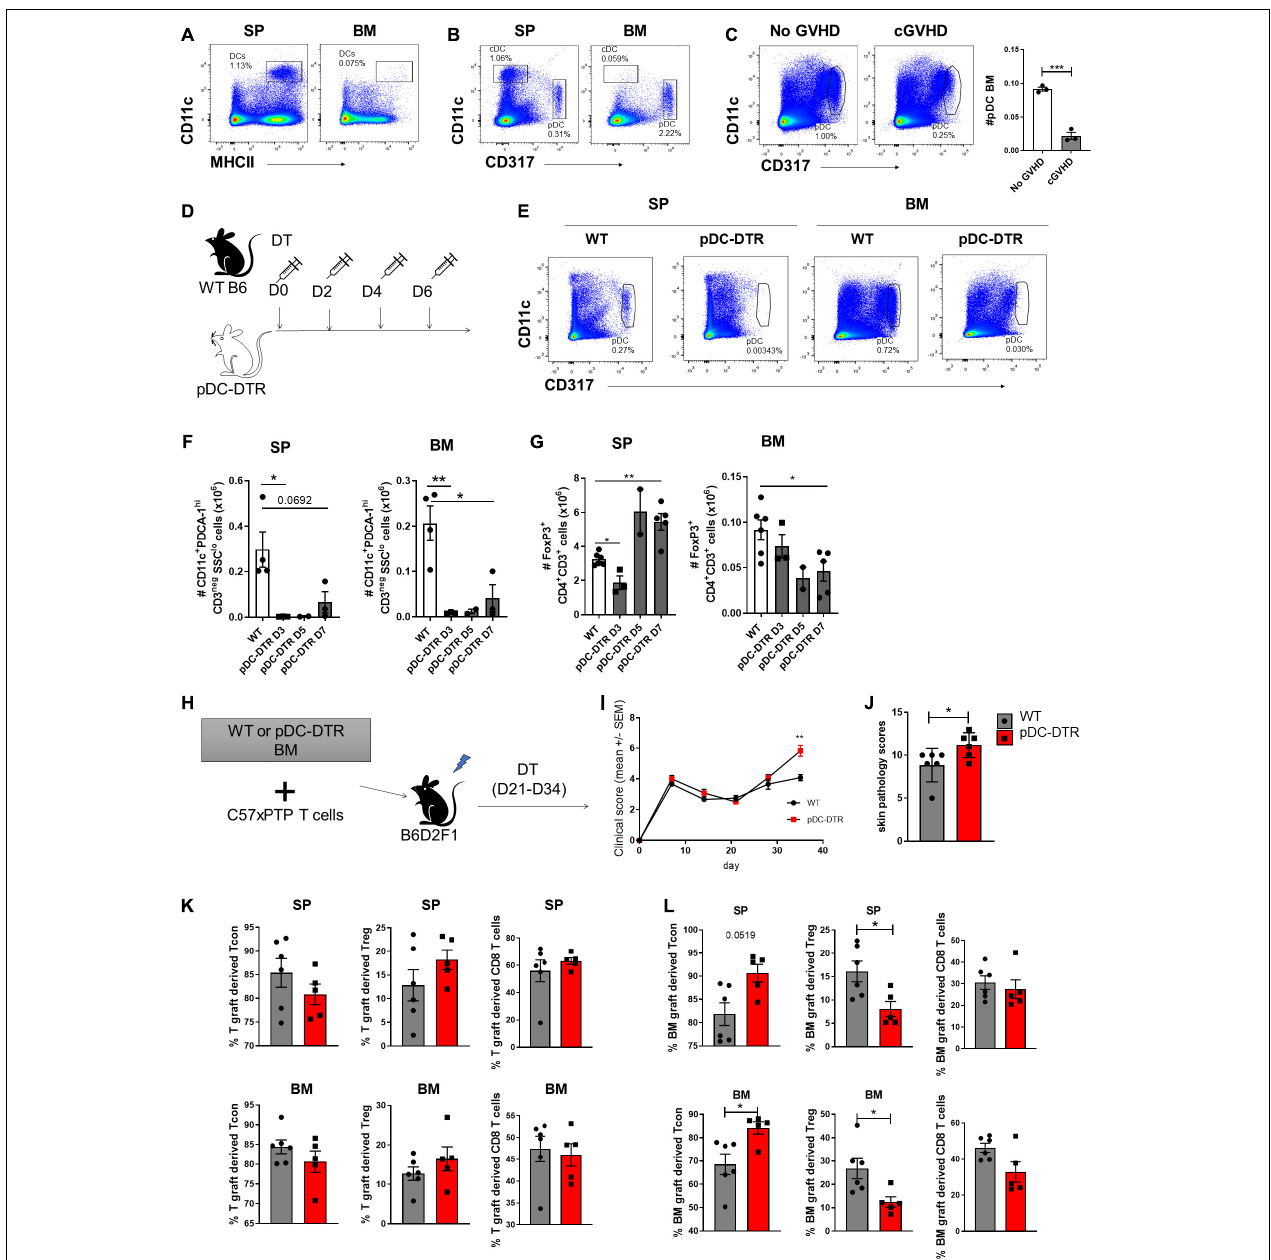
FIGURE 7 | pDCs are required for the BM-Treg maintenance in vivo . (A,B) Flow cytometry analysis of dendritic cell populations in SP and BM of naïve C57BL/6 (B6) mice. (A) Representative frequency (%) cDC (CD11c + MHCII + ) frequency (%) in the SP and BM. (B) Representative frequency (%) of pDC (CD11c low CD317 + ) in the SP and BM. (C) Irradiated allogeneic B6D2F1 (H2D b / d ) recipients were transplant with B6 BM with (cGVHD) or without (No cGVHD) B6 SP T cells. Representative analysis and enumeration of pDC populations in the SP and BM WT mice following allogeneic SCT. (D–G) BDCA2-DTR transgenic mice (pDC-DTR) or naïve B6 mice were administered with DT for 1 week to illicit a global depletion of pDCs. (D) Outline of DT administration strategy. (E) Representative flow analysis of cDC and pDC populations in the SP and BM following DT administration. (F) Enumeration of pDCs in the BM and SP of pDC-DTR mice following DT administration. (G) Enumeration of CD4 + FoxP3 + Treg in the BM and SP of pDC-DTR mice following DT administration. (H–L) Irradiated allogeneic B6D2F1 (H2D b / d ) recipients were transplanted with either WT B6 or pDC-DTR BM, supplemented with B6 SP T cells to induce cGVHD. Transplanted mice were administered with DT twice weekly from day 21 until day 34 following transplant. T cell populations were quantified by flow cytometry on day 35 post-transplant. (H) Outline of allogeneic transplant strategy. (I) Clinical scores and (J) skin pathology scoring from histopathology analysis of B6 or pDC-DTR BMgraft recipients ( n = 6). (K) Frequency (%) of Tgraft derived CD4 + Tcon and CD4 + FoxP3 + Treg in the SP and BM of B6 ( n = 6) or pDC-DTR ( n = 5) BMgraft recipients. (L) Frequency (%) of BMgraft CD4 + Tcon and CD4 + FoxP3 + Treg in the SP and BM of B6 ( n = 6) or pDC-DTR ( n = 5) BMgraft recipients. Data are shown as mean ± SEM. Statistical significance was determined using an unpaired 2-tailed Mann-Whitney U test or a paired t test where appropriate (* P < 0.05; ** P < 0.01; *** P < 0.001). Statistical analyses were performed using GraphPad Prism version 6.01 software. cDC conventional dendritic cell; pDC, plasmacytoid dendritic cell; pDC-DTR, BDCA2-DTR transgenic mice.